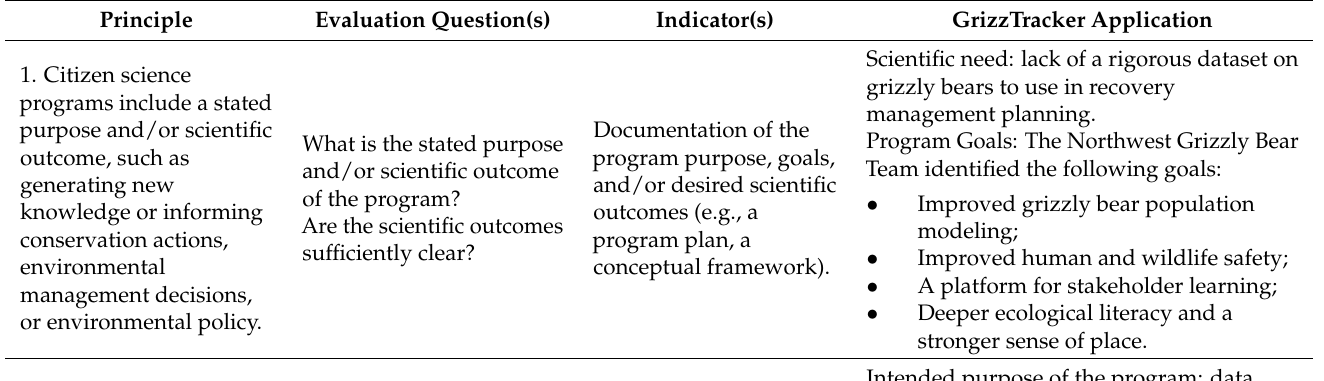
Table 2. Evaluation framework and